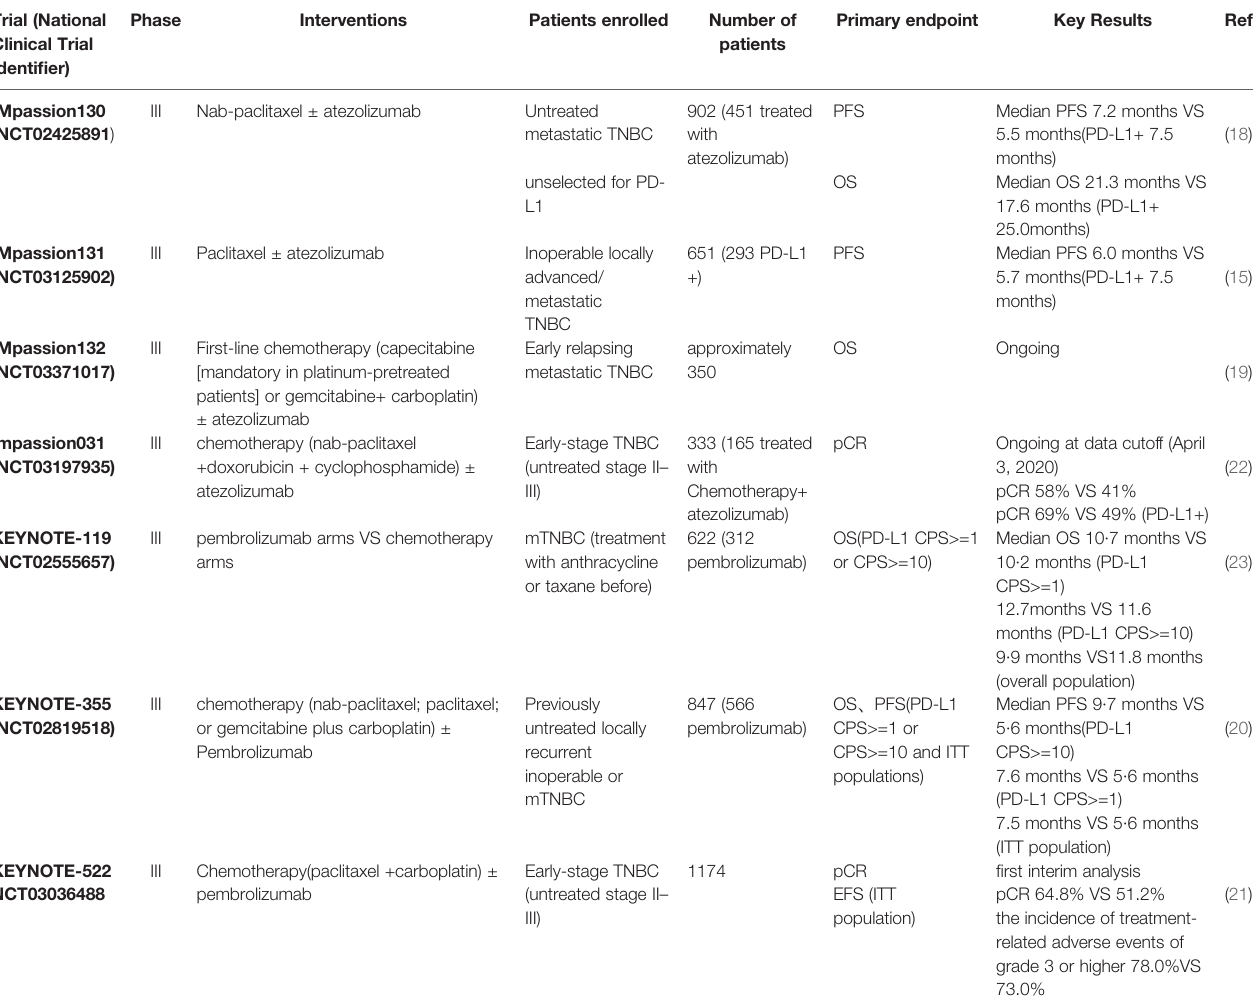
TABLE 1 | Summary of primary phase III clinical trials adding immunotherapy to chemotherapy in breast cancer. Trial (National Clinical